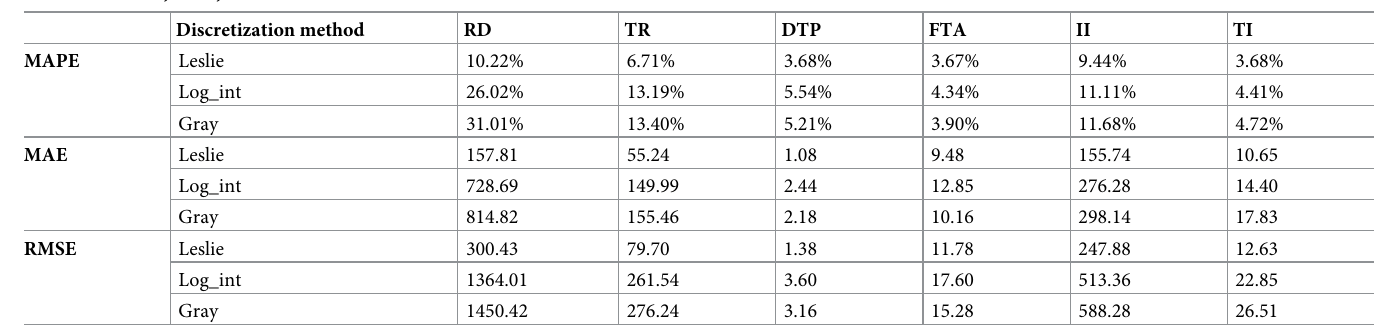
Table 10. MAPE, MAE, and